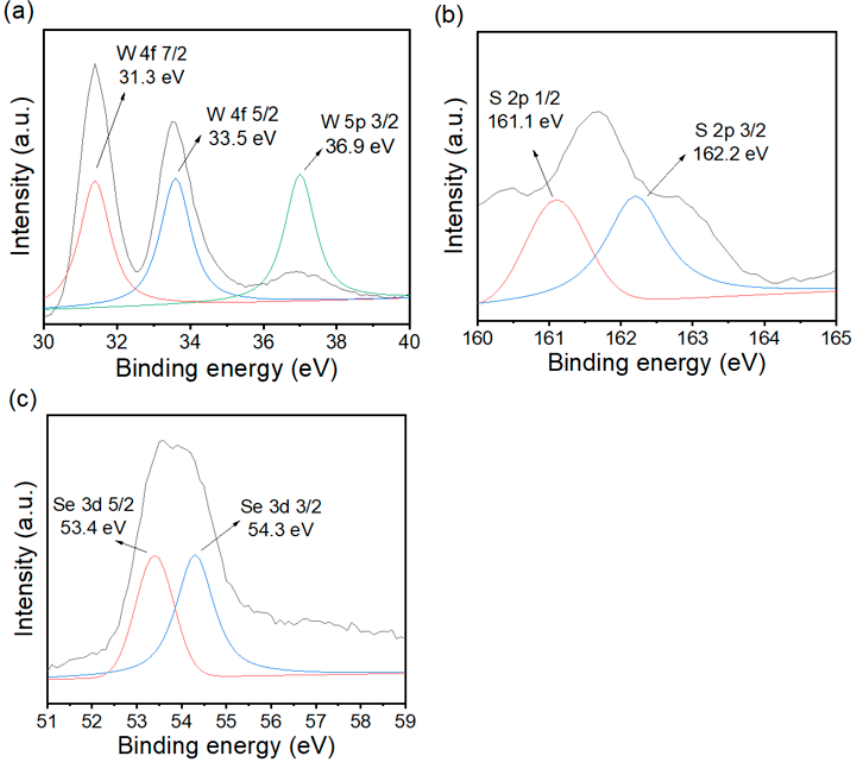
Figure 4. XPS survey spectra of WSSe-3. High-resolution XPS spectra of the ( a ) W 4f, ( b ) S 2p, and ( c ) Se 3d. Table 1. The physical adsorption parameters of the photocatalysts of WS 2 , WSe 2 , and WSSe-3 were measured three times.